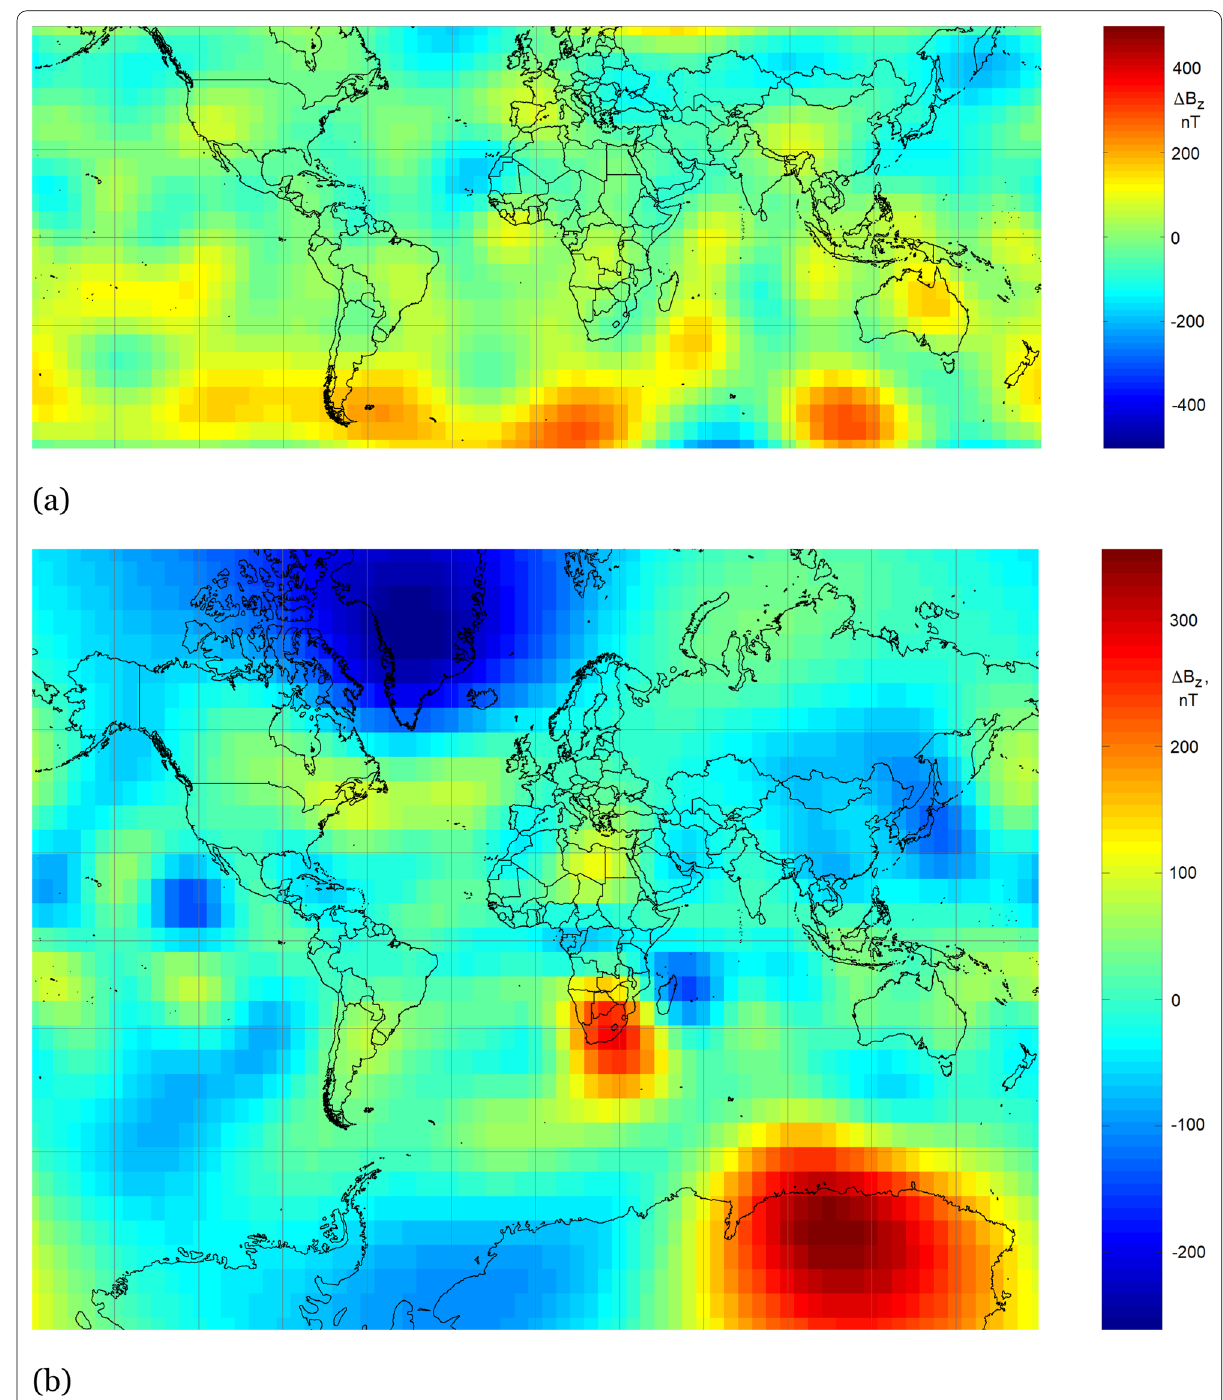
Fig. 8 Comparison of the new models based on the Kosmos-49 (N-1, a ) and Kosmos-321 (N-2, b ) measurements with the IGRF model for 1964 and 1970, respectively. Each map shows differences in the Z component of the geomagnetic field at the nodes of the regular geographic grid at a spherical surface with the mean Earth radius, 6371.2